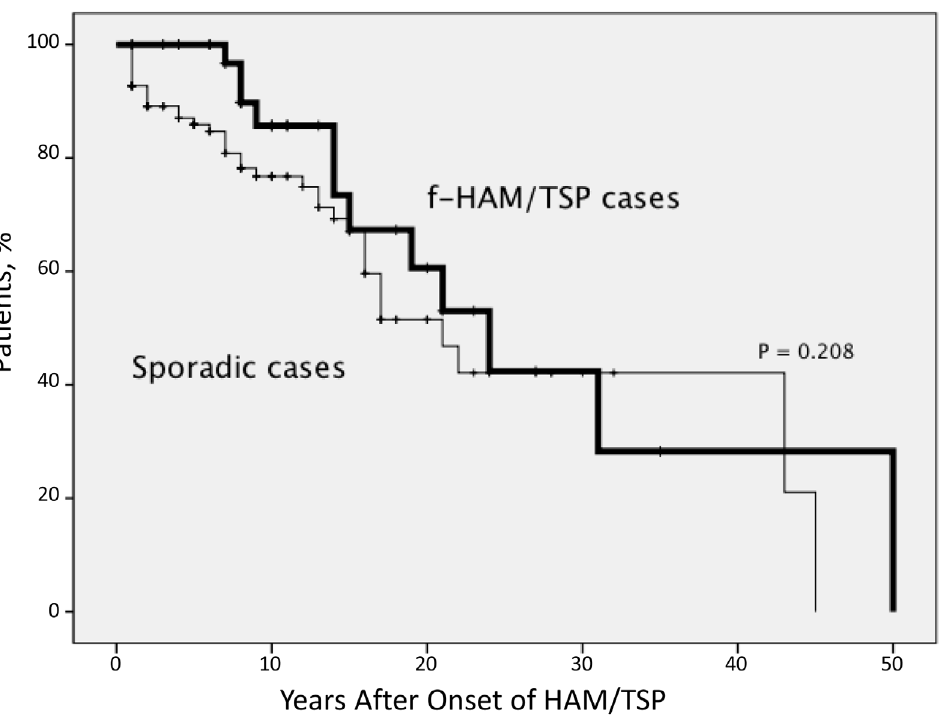
Figure 1. Kaplan–Meier estimates of the time from disease onset to assignment of motor disability scores of 6. In sporadic cases, more patients reached the score of six at an early stage; however, the difference was not significant. Approximately 30% of both f-HAM/TSP cases and sporadic cases needed a wheelchair in daily life in 15 years after onset and approximately 50% of patients from both groups needed a wheelchair in 20 years after onset.